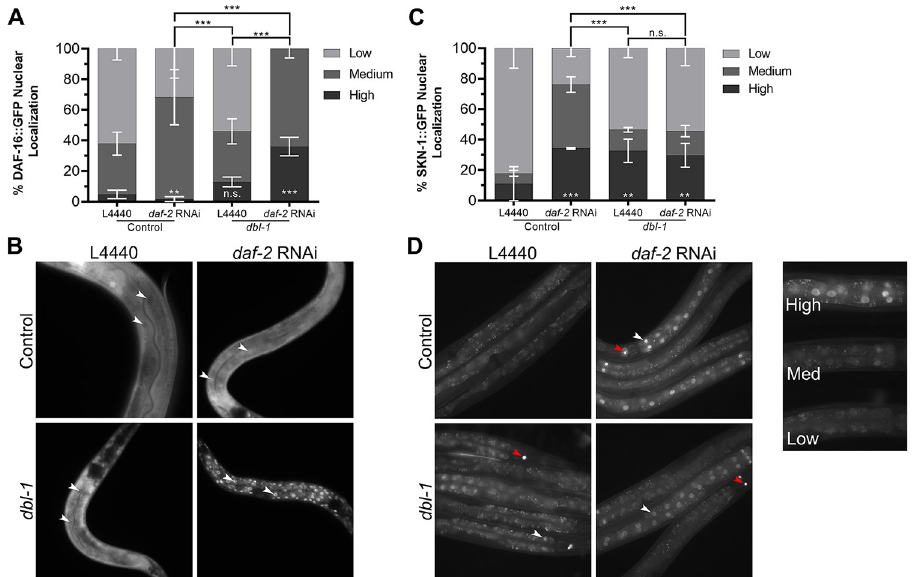
Fig 2. DAF-16 and SKN-1 localization are altered in a dbl-1 mutant background. A) Control animals treated with empty vector exhibit some nuclear localization of DAF-16::GFP, upon treatment with daf-2 RNAi, DAF-16::GFP nuclear localization increases. In dbl-1 mutants, DAF-16::GFP nuclear localization is not significantly changed compared to the control under empty vector treatment. Upon treatment with daf-2 RNAi, a higher level of nuclear localization is observed in dbl-1 mutants as compared to control animals treated with daf-2 RNAi. B) Images of animals expressing DAF-16::GFP taken at 400X. White arrows indicate examples of intestinal nuclei. C) Control animals treated with empty vector exhibit very little nuclear localization of SKN-1::GFP. Upon treatment with daf-2 RNAi, SKN-1::GFP nuclear localization drastically increases. In dbl-1 mutants, SKN-1::GFP nuclear localization is slightly increased compared to the control under empty vector treatment. dbl-1 mutants treated with daf-2 RNAi displayed no change in nuclear localization. D) Images of animals expressing SKN-1::GFP were taken at 200X. White arrows indicate examples of nuclei, red arrows indicate SKN-1::GFP expression in ASI neurons. Nuclear localization was graded as high, medium, or low, with an example of each ranking shown. Asterisks across the bottom represent significance compared to Control, n.s. not significant, �� p < 0.01, ��� p < 0.001, error bars represent SEM. Camera settings were identical between all strains.